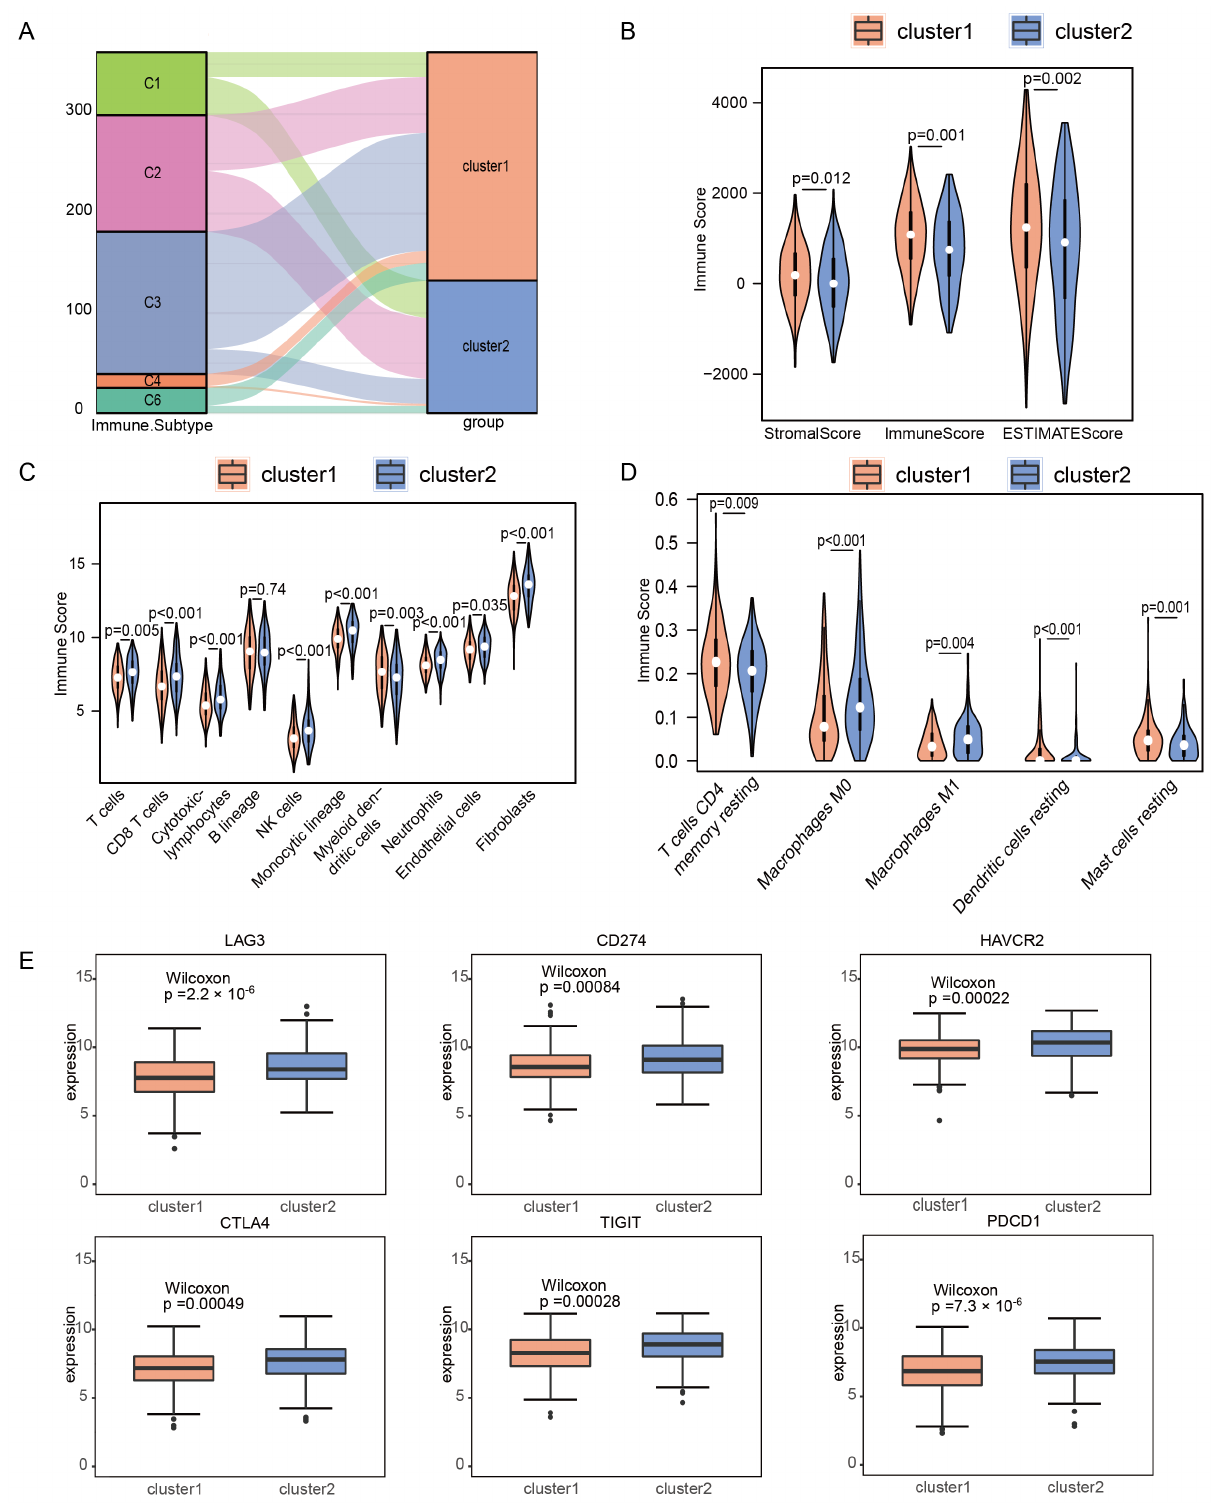
Figure 2. Immune landscape of m6A/m5C subtypes in the early-stage TCGA-LUAD cohort. ( A ) Comparison between the m6A/m5C subtypes established in this study and immune subtypes in existing TCGA cancers. ( B ) Stromal score, immune score and estimate score between the m6A/m5C subtypes. ( C ) Comparison of immune scores calculated using MCPcounter between the m6A/m5C subtypes. ( D ) Comparison of immune scores calculated using CIBERSORT between the m6A/m5C subtypes. ( E ) The expression of immune checkpoint molecules in m6A/m5C